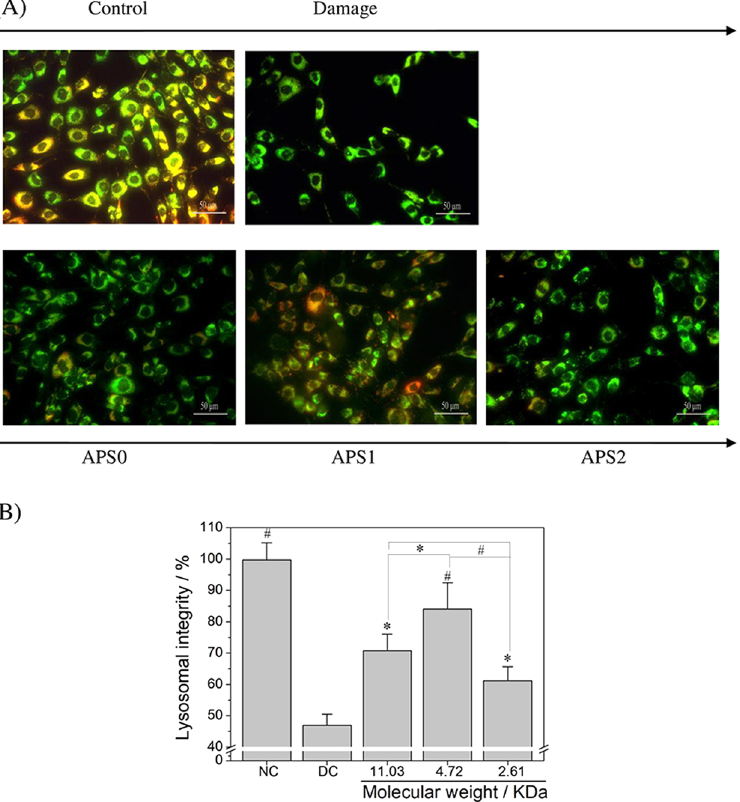
for 10 h. ( A ) The fluorescence microscope images of lysosome integrity. ( B ) Quantitative analysis results of lysosome integrity. Compared with DC group, * P < 0.05, # P <